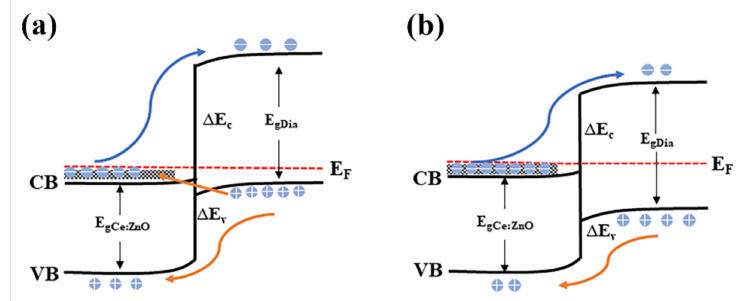
Figure 5. Schematic of the energy band structure of the n-Ce:ZnO/p-BDD heterojunction at various temperatures. ( a ) Room temperature, ( b ) high temperature.